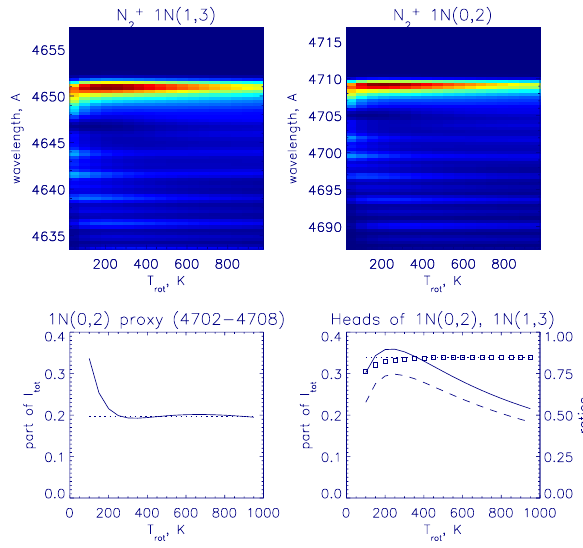
Fig. 4. Top: rotational structure of 1N(1,3) and 1N(0,2) bands, syn- thetic spectra are convolved with the instrument function for various rotational temperatures of the parent N 2 . Bottom left – the bright- ness of Proxy(0,2) relative to the total N + 1N(0,2) band brightness 2 as a function of the rotational temperature. Bottom right – bright- nesses of the Head(0,2) (solid line) and Head(1,3) (dashed line) rel- ative to the total brightness of the respective band, as a function of the rotational temperature. Squares show the ratio of the dashed curve to the solid (axis on the